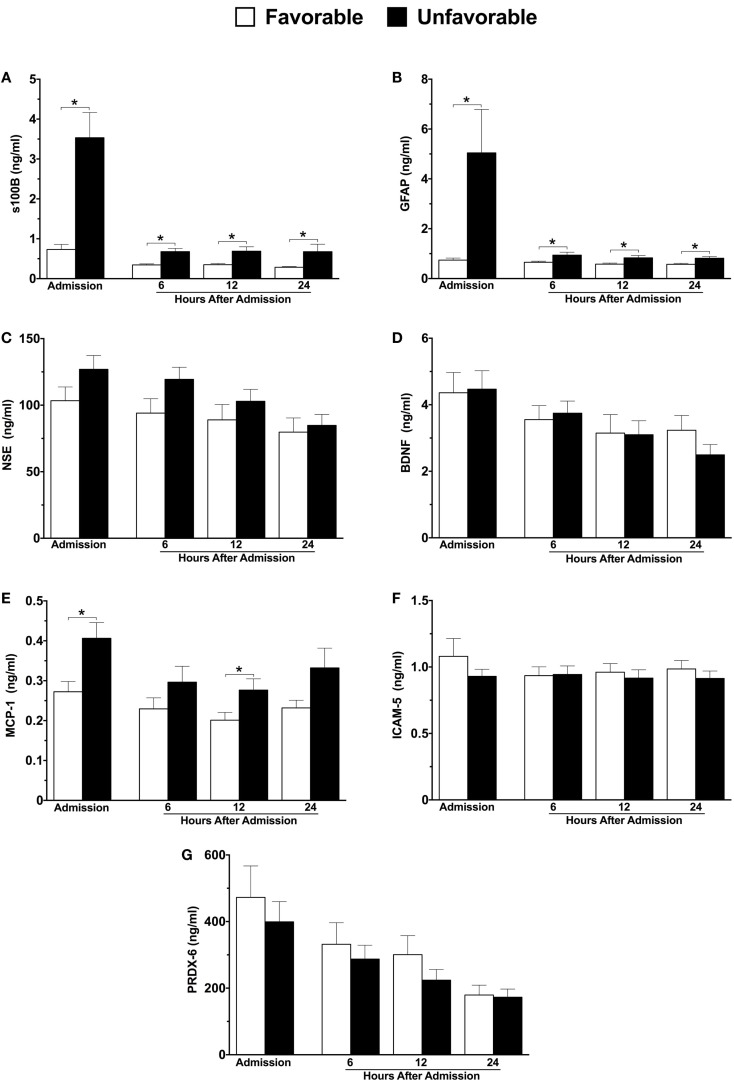
Plasma concentrations of neuroinjury biomarkers in combined moderate-to-severe TBI patients within the first 24 h of hospital admission, stratified according to 6-month neurological outcome using the extended Glasgow outcome scale (GOSE) score. Favorable outcome = GOSE 5–8, n = 35; Unfavorable outcome = GOSE 1–4, n = 50. s100 calcium binding protein (A), glial fibrillary acidic protein (B), neuron specific enolase (C), brain-derived neurotrophic factor (D), monocyte chemoattractant protein-1 (E), intercellular adhesion molecule-5 (F), peroxiredoxin-6 (G). Sample sizes may vary. *p ≤ 0.05 by Student’s t-test or Mann–Whitney U, where appropriate, versus patients with a favorable outcome.